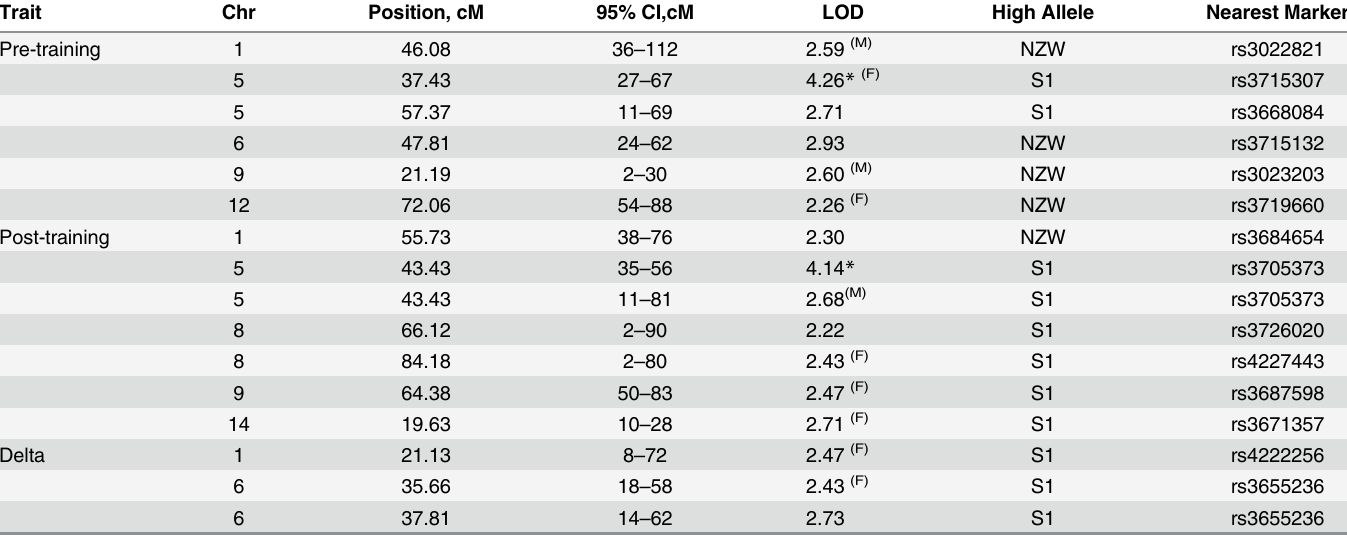
Table 2. Significant and suggestive QTL for pre-training, post-training, and change in exercise time in NZW/LacJ x 129S1/SvImJ F 2 mice.